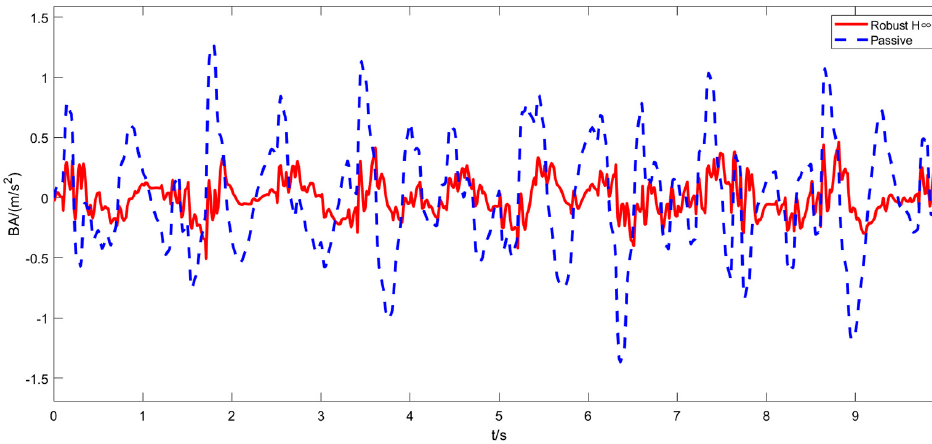
Figure 7. Random road body acceleration responses of passive and active suspensions.